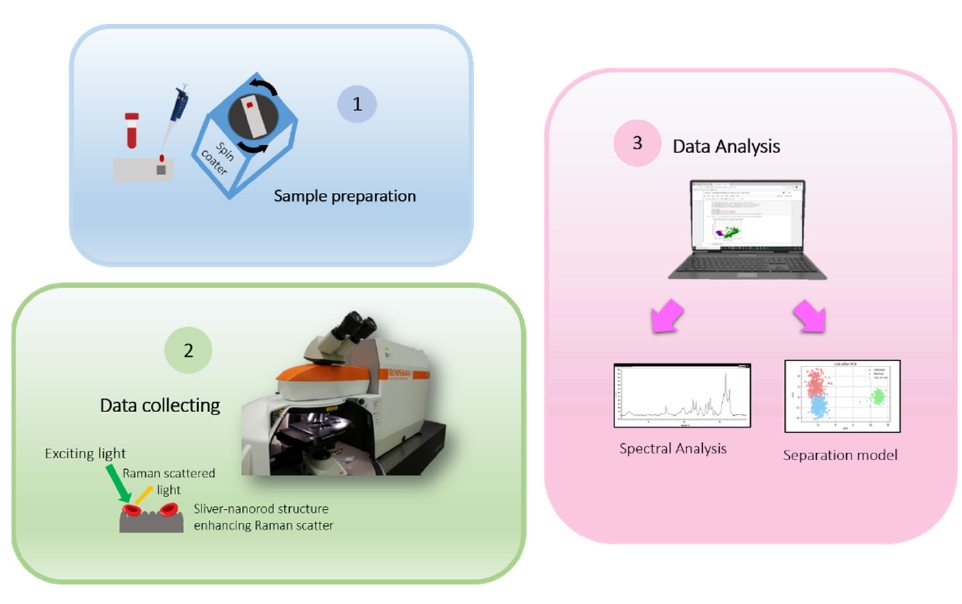
Figure 1. Diagram of the Methodology.